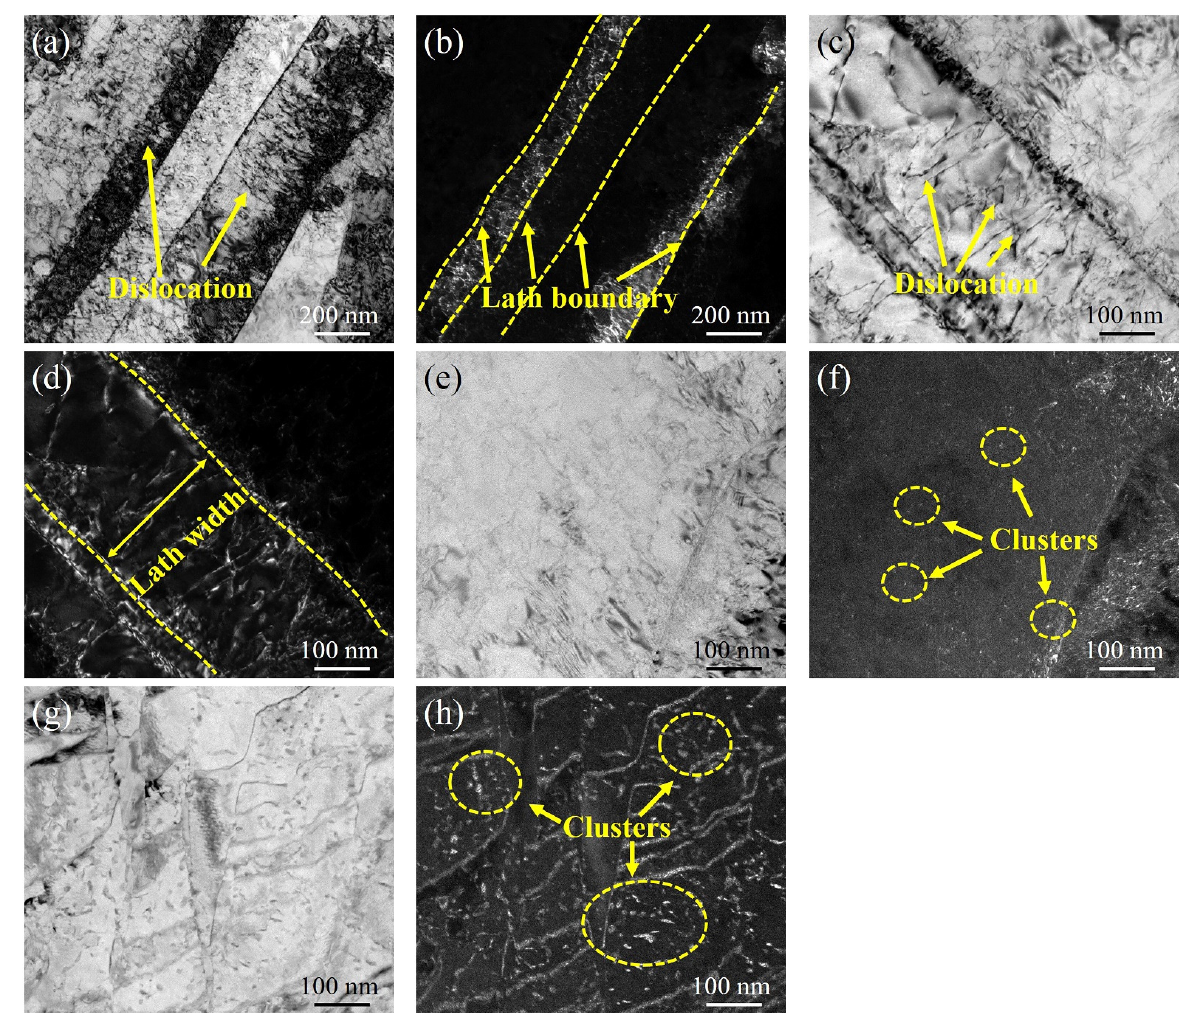
Figure 3. TEM morphology of the specimens under various thermal conditions: ( a ) bright-field im- age of DC, ( b ) dark-field image of DC, ( c ) bright-field image of 480A-0.5, ( d ) dark-field image of 480A-0.5, ( e ) bright-field image of 480A-4, ( f ) dark-field image of 480A-4, ( g ) bright-field image of 480A-80, and ( h ) dark-field image of 480A-80.